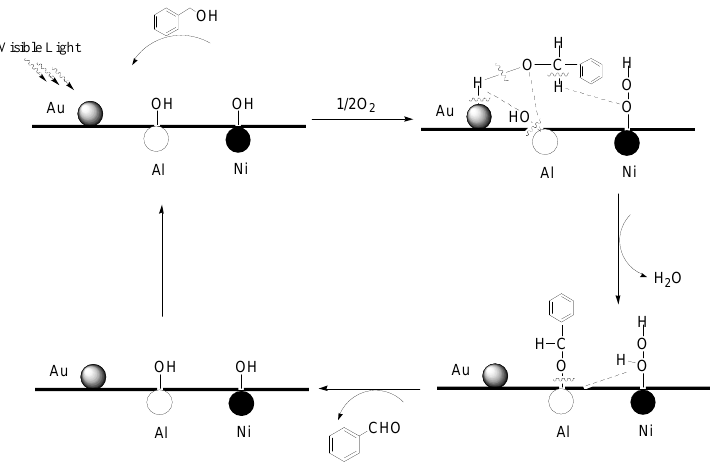
Scheme 1. The mechanism for the photocatalytic aerobic oxidations of benzyl alcohol using 3 wt. % Au/Ni 3 Al